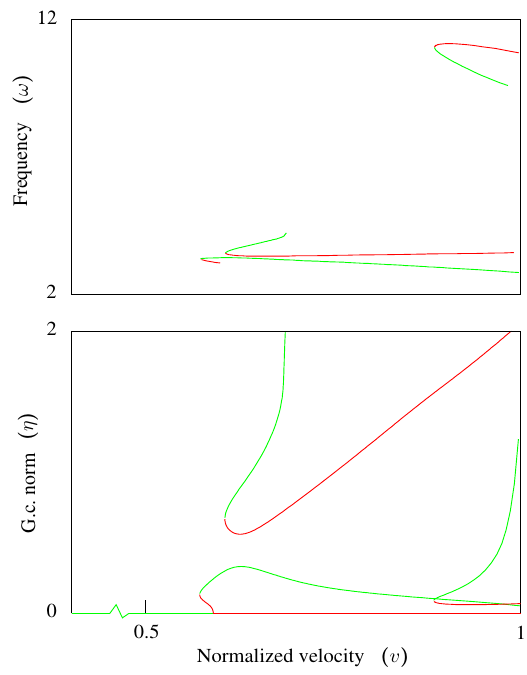
Figure 12. Complete LCO boundaries, v - η and v - ω views (Green means stable, red means